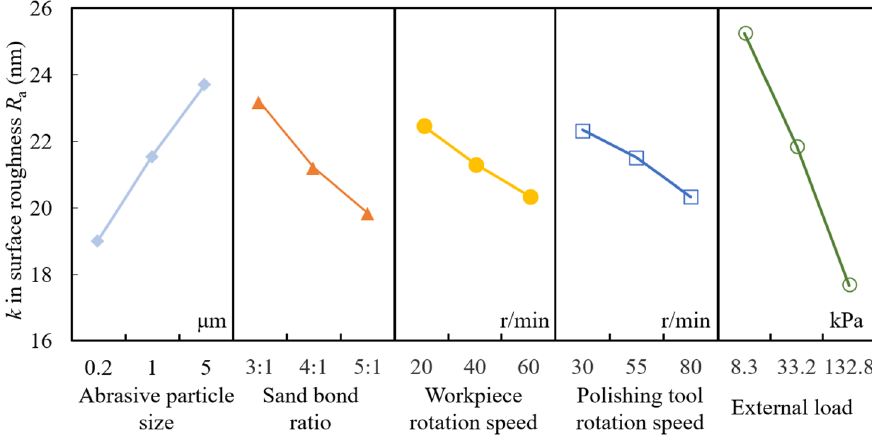
Figure 7. Relationship between parameters and surface roughness R